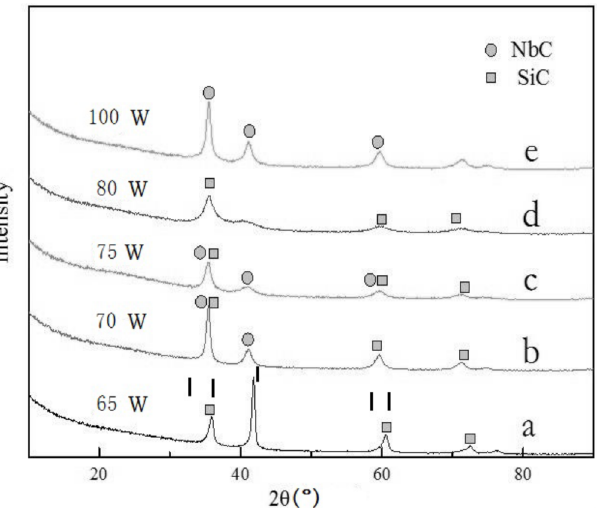
Figure 1. X-ray diffraction patterns of the five deposited thin films (a to e). The vertical marks are the simulated XRD peaks of Nb 4 SiC 3 phase. The three strongest peaks in the experiment are in good agreement with the simulated data.